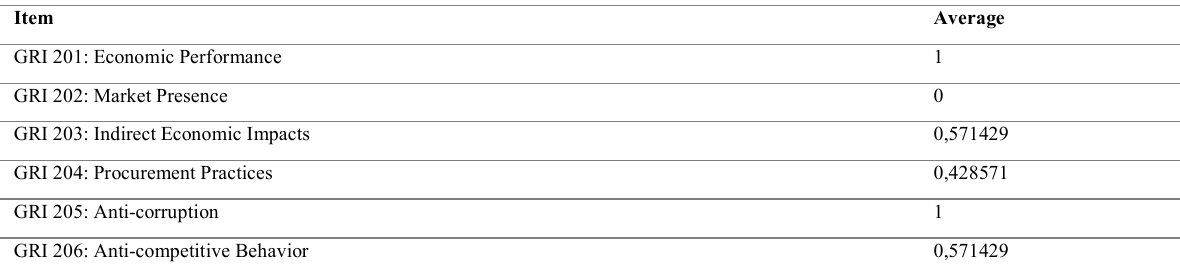
Table 2. Economic Item